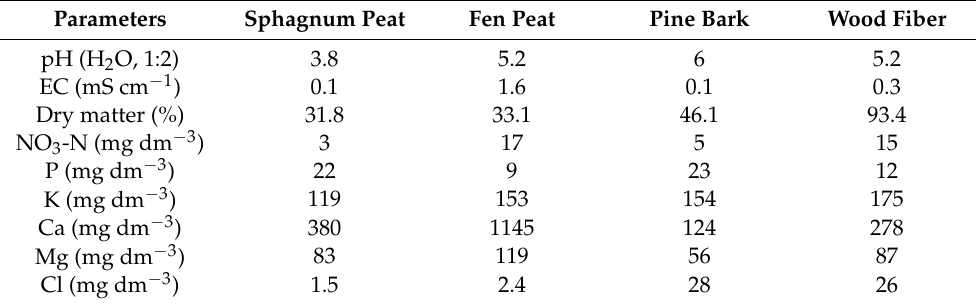
Table 2. pH,electricalconductivity(EC),drymatterandnutrientconcentrationsofgrowingmediacomponents.